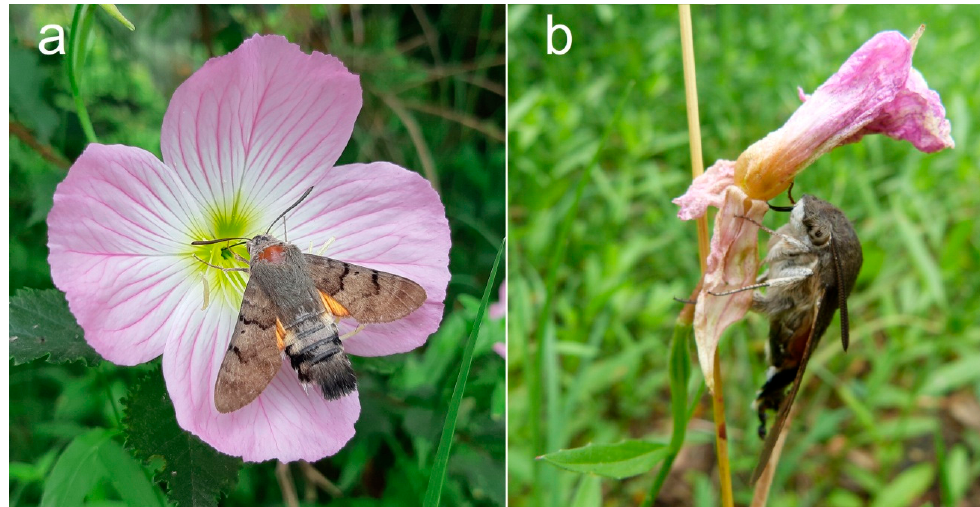
Figure 1. Two specimens of the hummingbird hawkmoth Macroglossum stellatarum stuck with their proboscides in the flowers of Oenothera speciosa . In the first picture ( a ), the flower is newly bloomed, while in the second picture ( b ), the flower is wilted, so it can be hypothesized that the moth was stuck for several hours. Photo credit: Andrea Bonifazi.